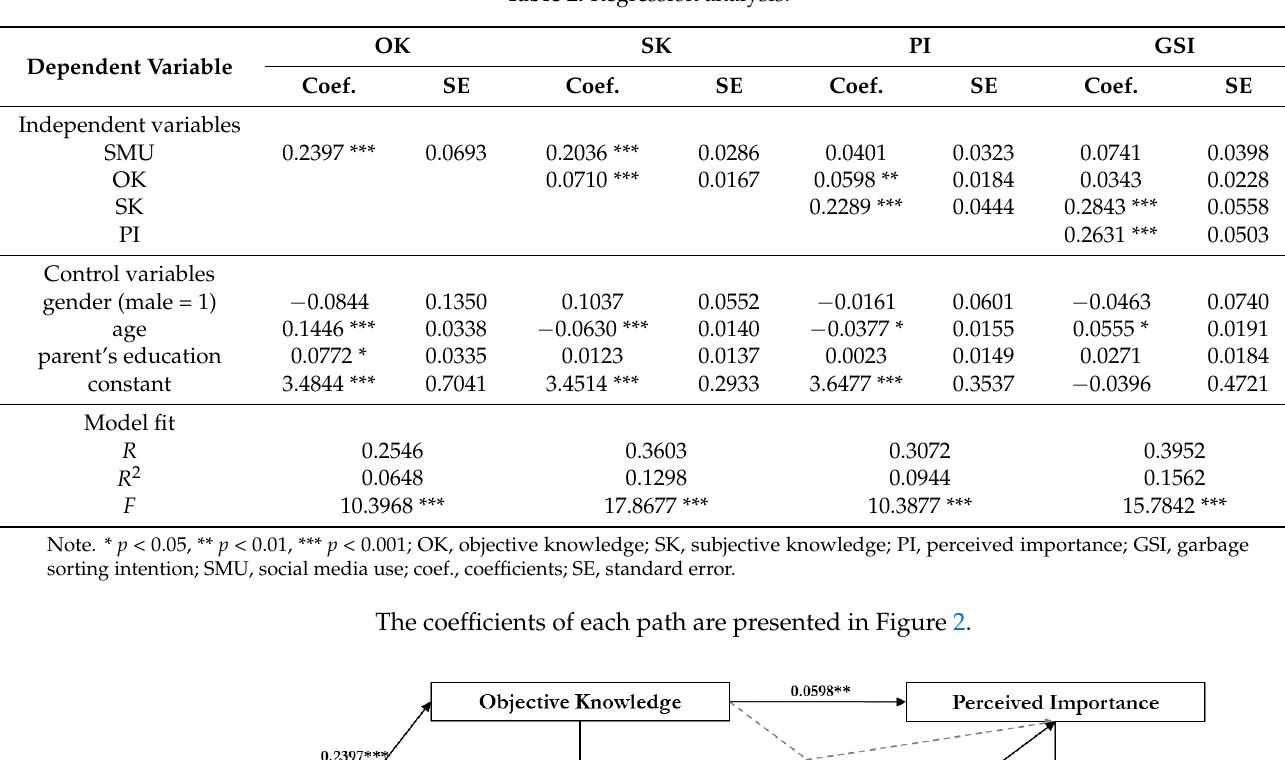
Table 2. Regression analysis.